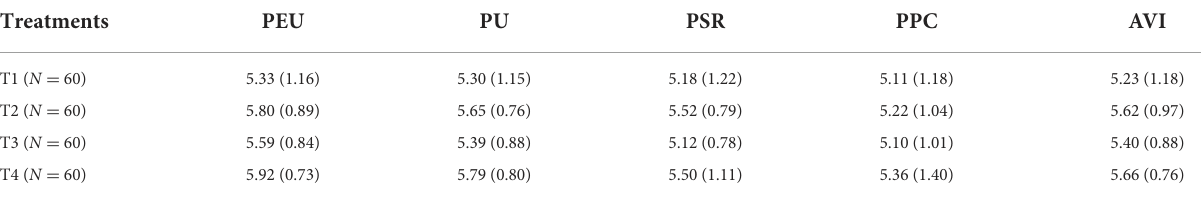
TABLE 7 Descriptive statistics per treatment.